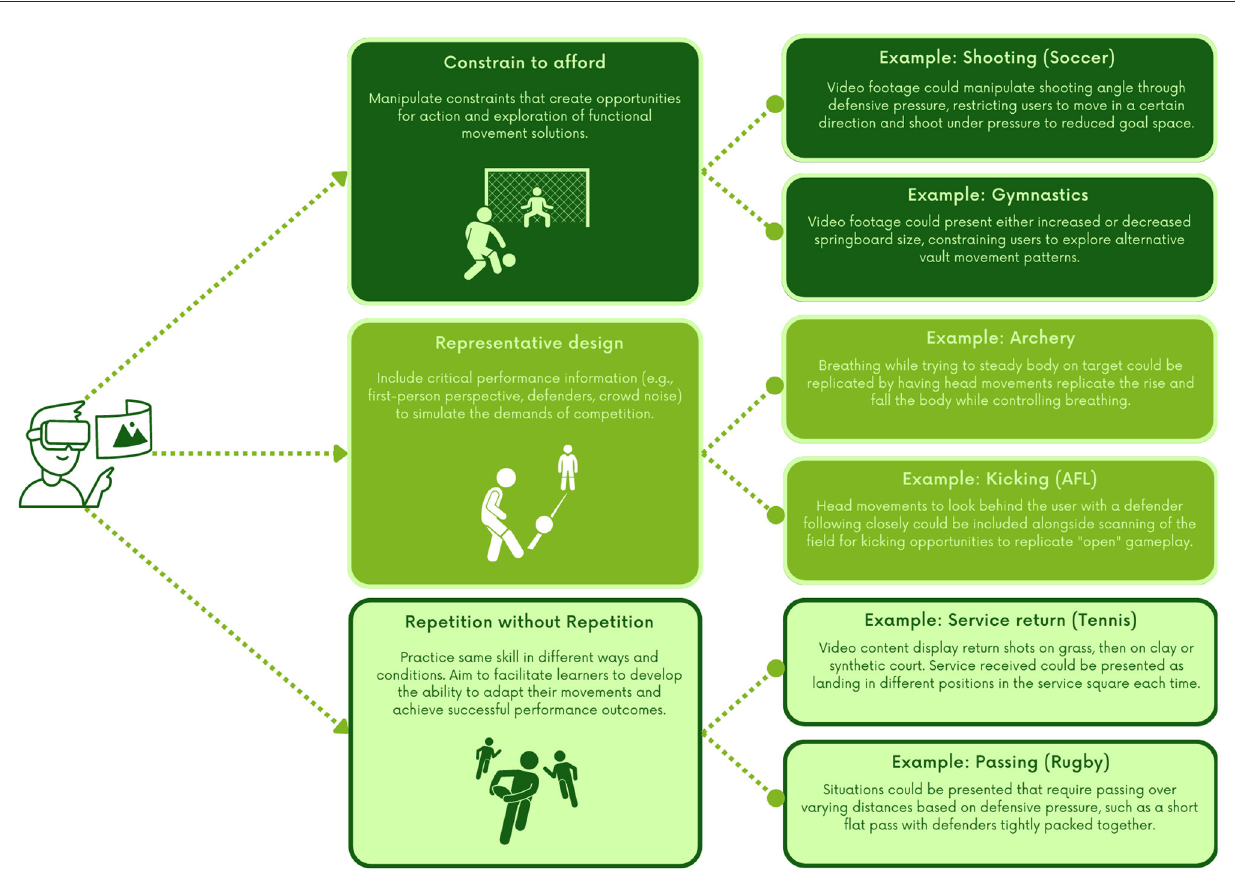
FIGURE1 Practical applications for CLA to 360 ◦ VR practice